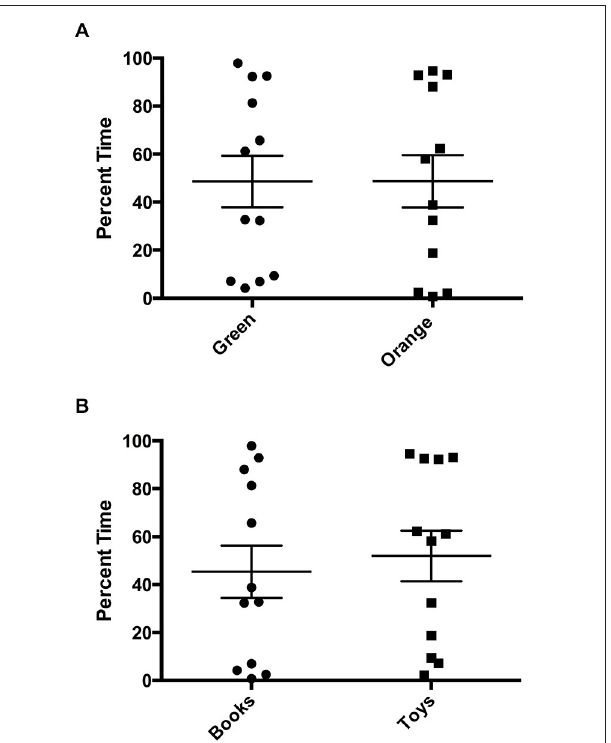
FIGURE 4 | Final preference test times. (A) Independent from which unconditioned stimulus (US) was used for training, there were no significant differences in percent time spent in each room during the final preference test ( p > 0.05). (B) Independent from which room was paired with the US, there were no significant differences in percent time spent with US (books vs. toys), ( p > 0.05). Individual data points are plotted with the Mean ± SEM.